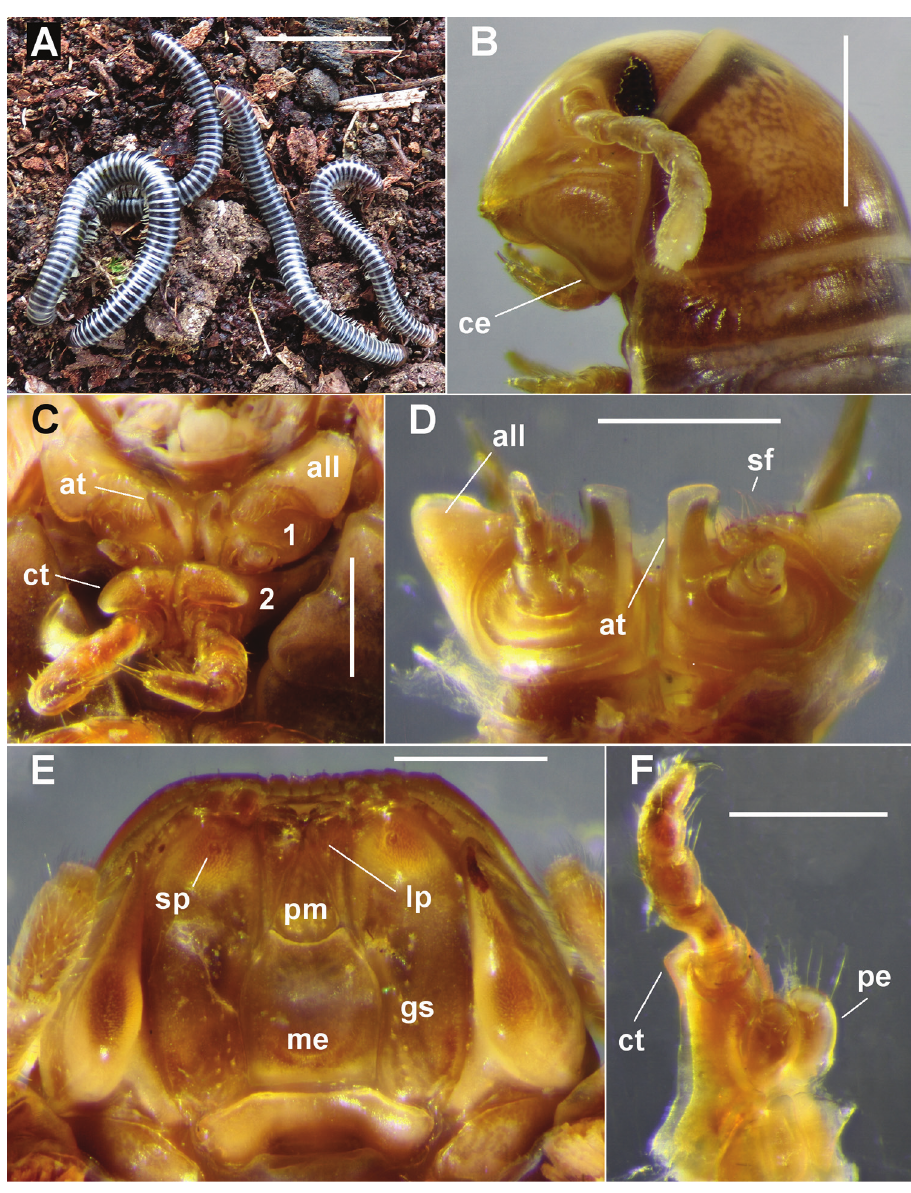
Figure 12. Equestrigonus tasmaniensis gen. n., sp. n. A Living animals before preservation in QVM 23:54467 B–F male paratype ex QVM 23:54094 B Head, left lateral view, showing ventral projection (ce) of cardo. C Dissection with head removed, ventral view, showing leg 1 complex and legs 2 in situ. all = anterolateral extension of leg 1 coxosternite, at = anterior tab of leg 1 prefemur, ct = coxal tab of leg 2 D Dissected leg 1 complex, posteroventral view; sf = field of setae E Gnathochilarium, ventral view; gs = gnathochilarial stipes, lp = lingual plate, me = mentum, pm = promentum, sp = pit on gnathochilarial stipes F Right leg 2, right posterolateral view (left leg removed for clarity); pe = left leg penis. Scale bars: A = 10 mm, B = 1.0 mm; C–F = 0.5